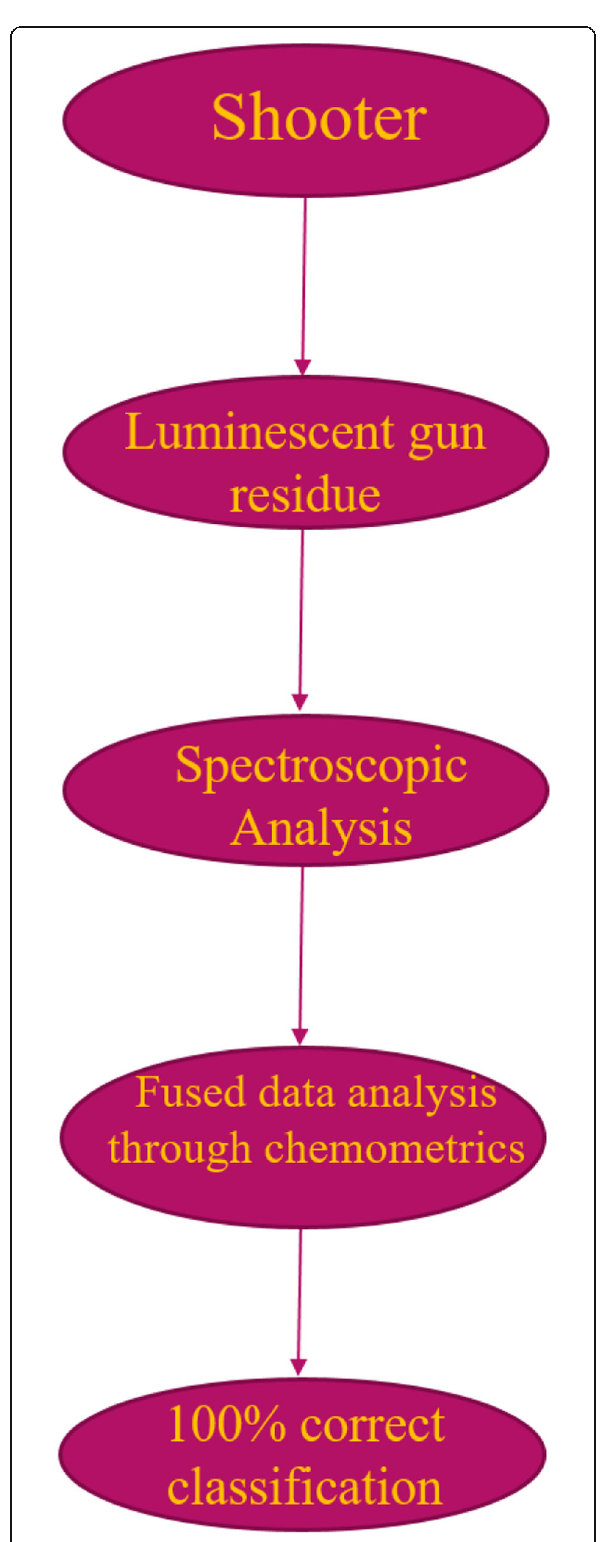
Fig. 1 Graphical representation of identification of